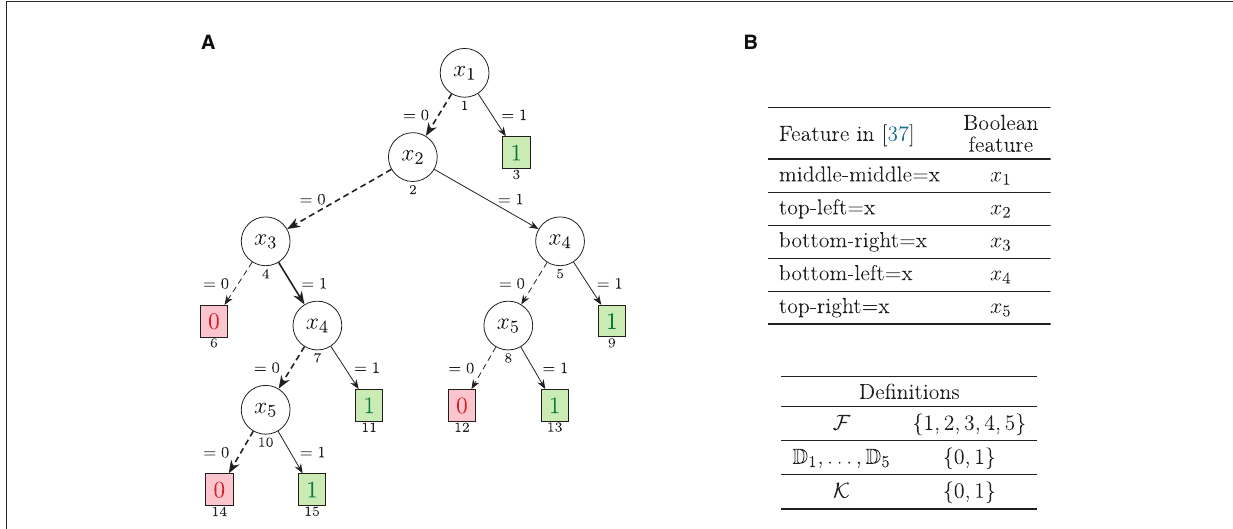
FIGURE1 Decision tree, adapted from (Hu et al., 2019, Figure 5b), for the tic-tac-toe dataset. This DT is also studied more recently in Izza et al. (2022a) and Marques-Silva (2022). Each feature tests a possible play for the X player. The (boxed) terminal nodes display the predicted class. The (circled) non-terminal nodes display the tested feature. The edges label depicts the feature’s tested literal, for the edge to be consistent. The number below each node denotes a unique number given to each node, which enables representing paths in the DT. (A) Decision tree. (B) Mapping of